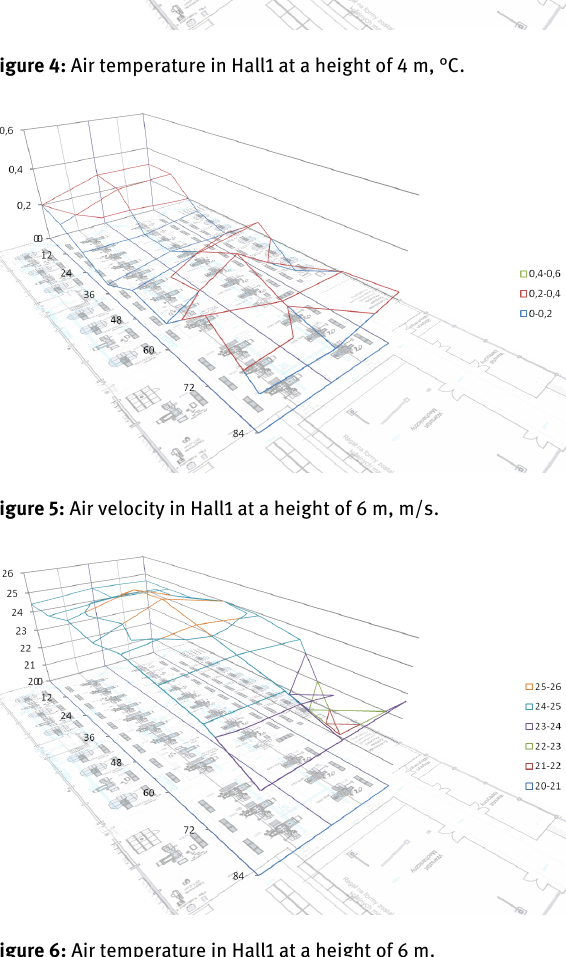
Figure 3: Air velocity in Hall1 at a height of 4 m, m/s.